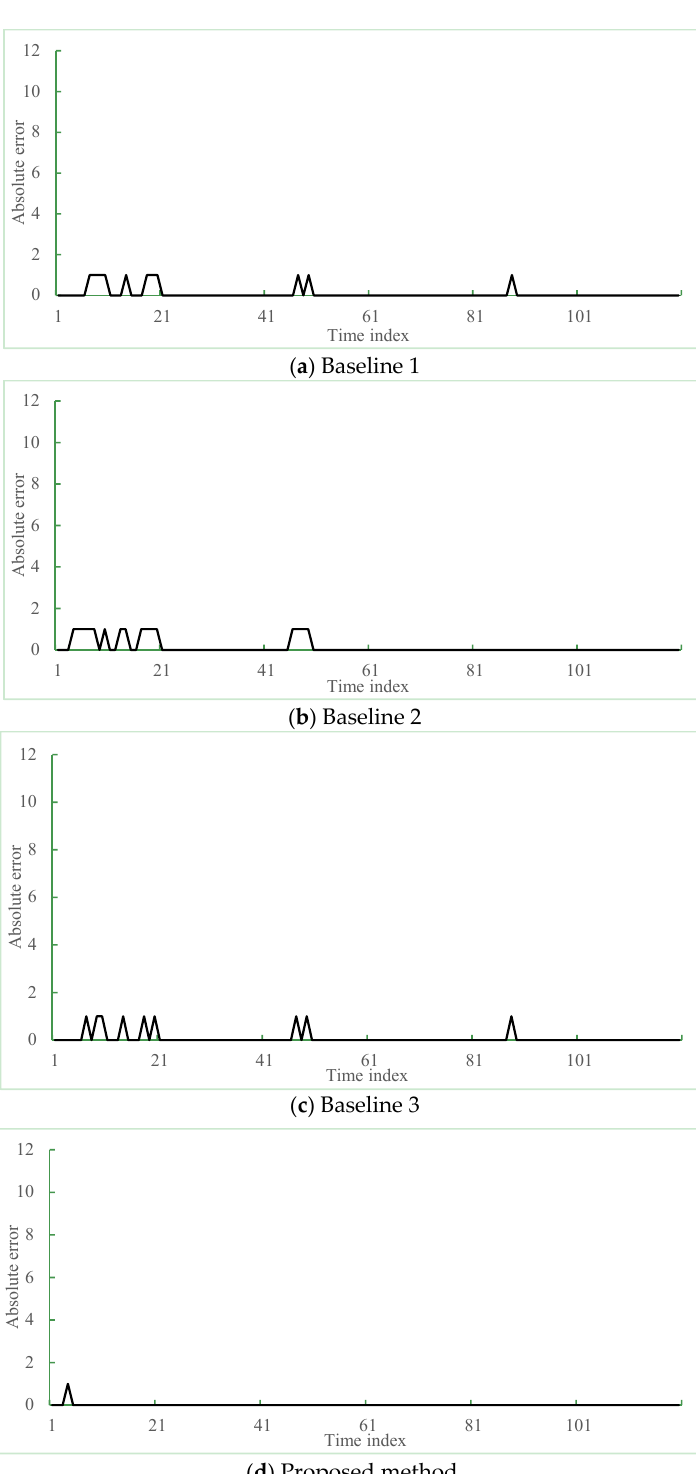
Figure 13. Performance comparison between three existing methods and the proposed method: ( a – c ) prediction errors of three baseline methods and ( d ) the proposed method. Table 4. Comparison of computational time using four methods at one cone ‐ zone on the Gyeongbu expressway.